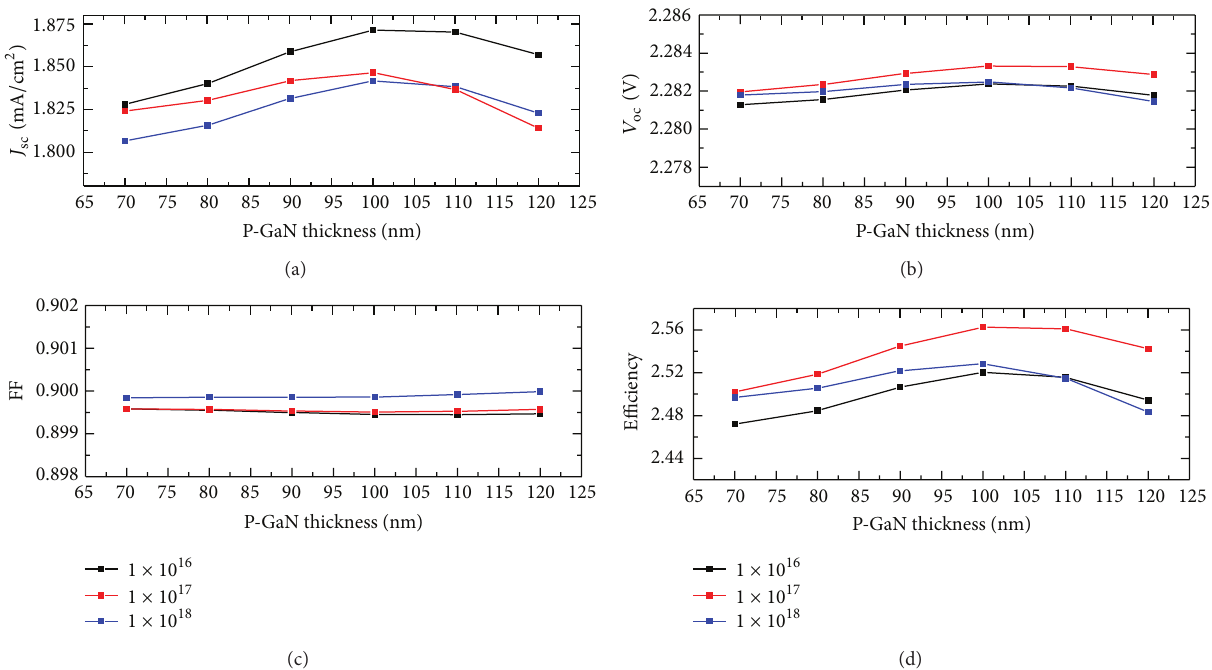
Figure 2: Effect of p-GaN layer thickness and doping concentrations on GaN/InGaN solar cell characteristic parameters: (a) short circuit current density, (b) open circuit voltage, (c) fill factor, and (d) efficiency.